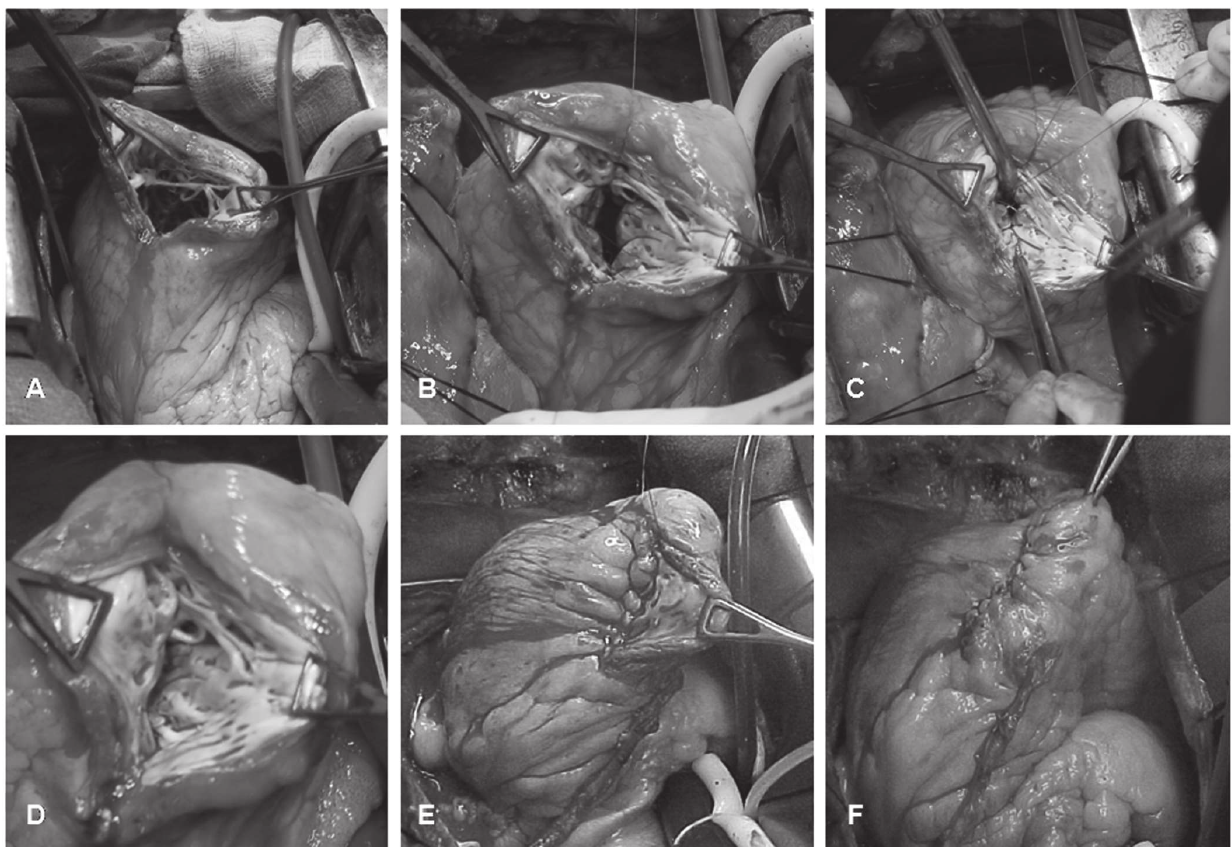
Fig. 1 - Stepwise sequence of the operative technique as described in text; aneurysm of the left ventricular anterior